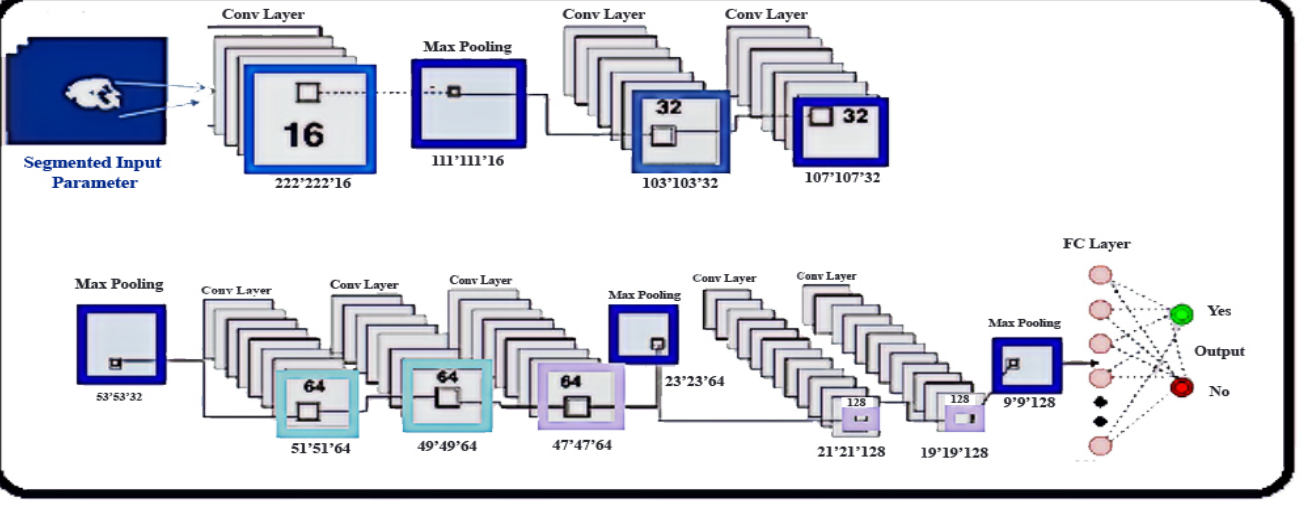
Figure 6. Diagrammatic representation on cascaded CNN architecture on brain tumor segmenta- tion.